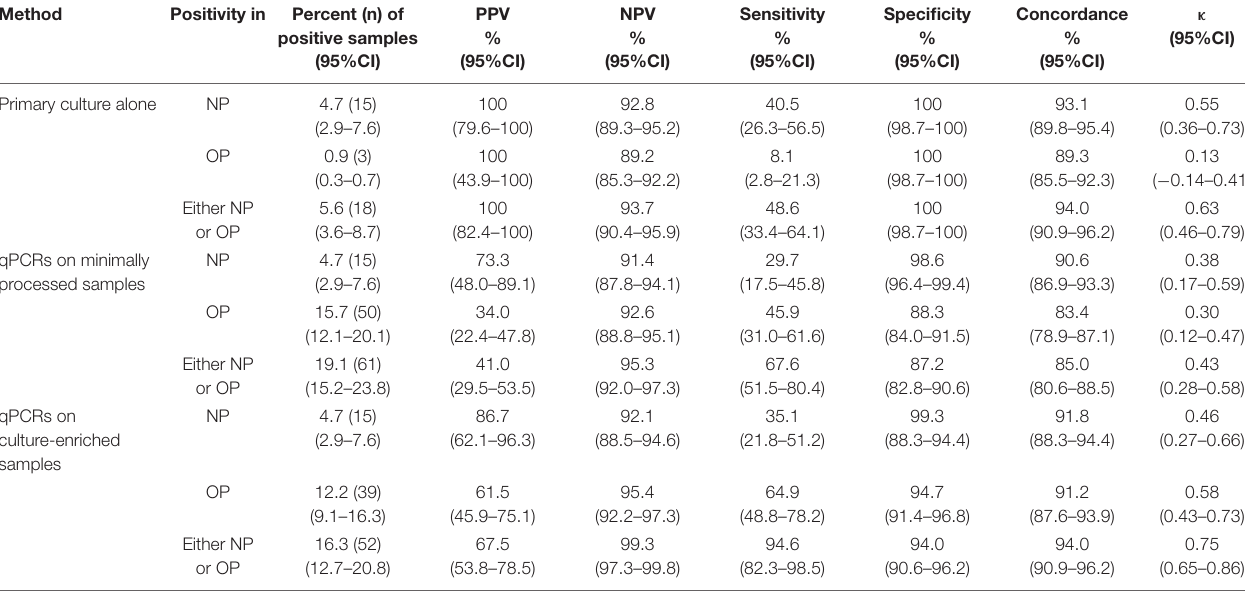
TABLE 4 | The accuracy of Streptococcus pneumoniae detection in paired nasopharyngeal and oropharyngeal samples from n = 319 adults tested using molecular methods applied to DNA extracted from minimally processed and culture-enriched samples and applying ROCd C q thresholds for a sample positivity in qPCRs.